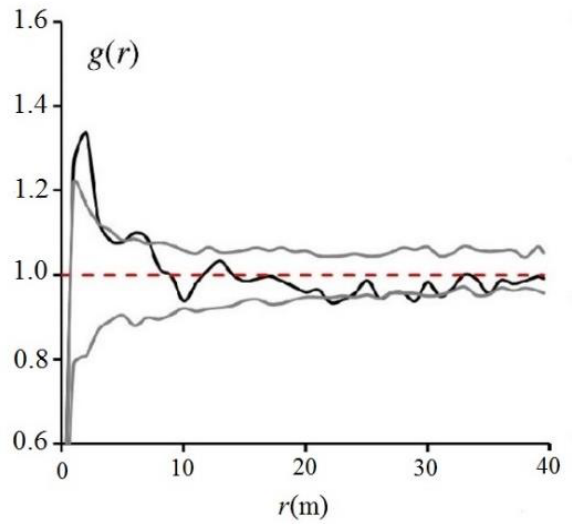
Figure 7. The inhomogeneous nearest neighbour distribution function D ( r ) displayed the aggregation of eshnan shrubs.